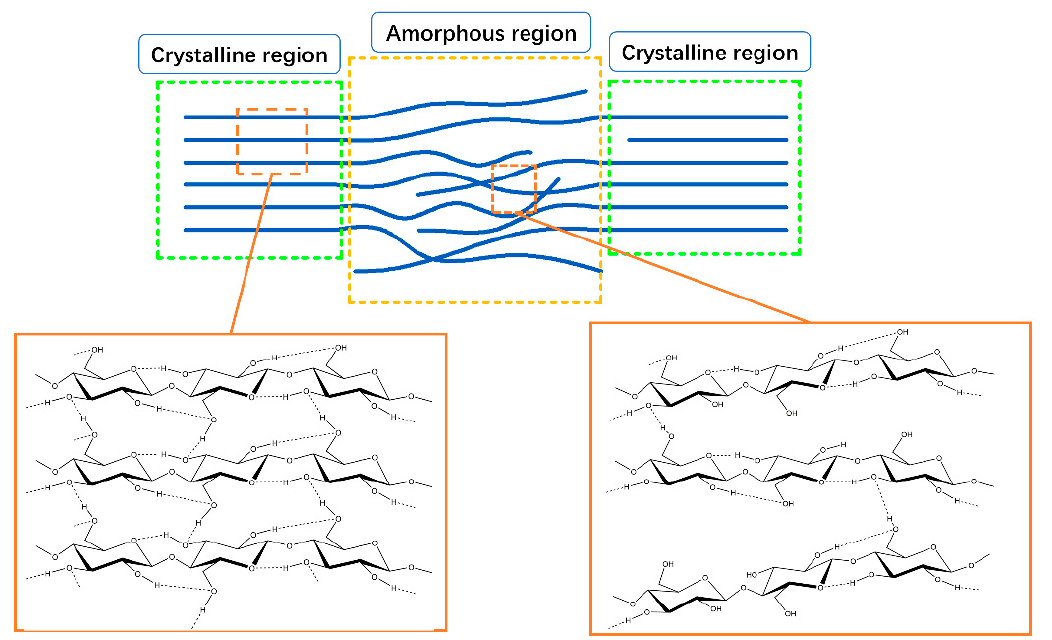
Figure 9. The illustration of a two-phase structure of cellulose.